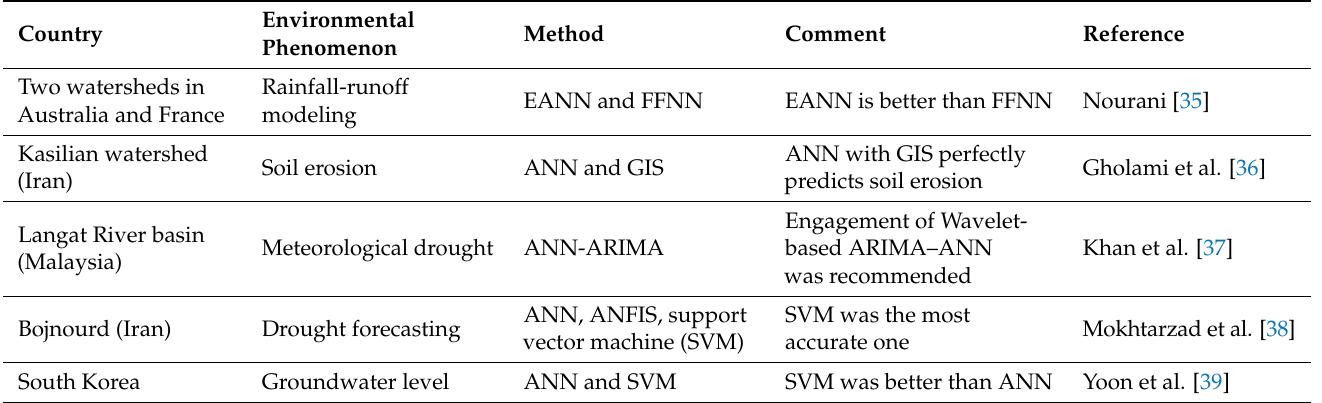
Table 2. Implementation of ANN for predicting some environmental variables in many parts of the